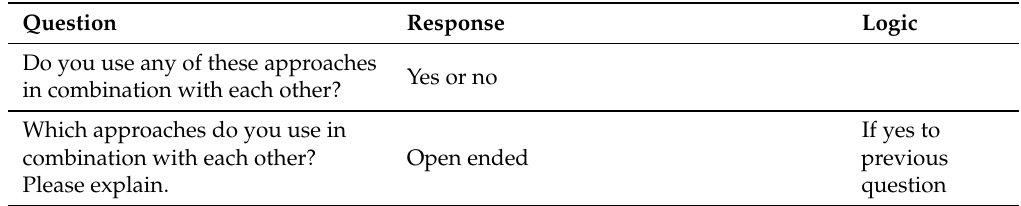
Table A4. Questions about how respondents approach design